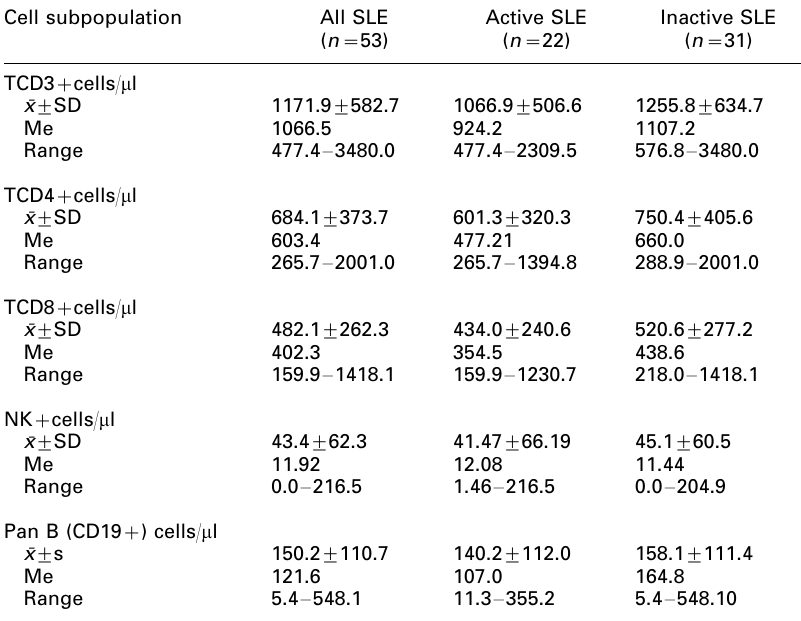
Table 3. Lymphocyte subpopulations in patients with SLE Cell